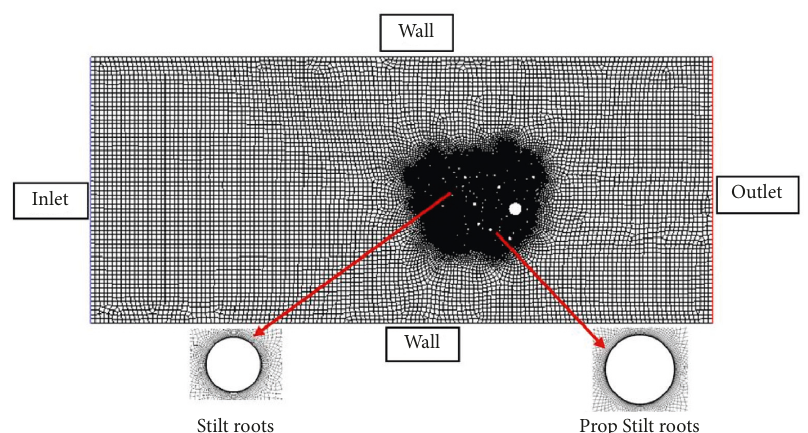
Figure 3: Rhizophora mangrove roots grid model created in ANSYS workbench.